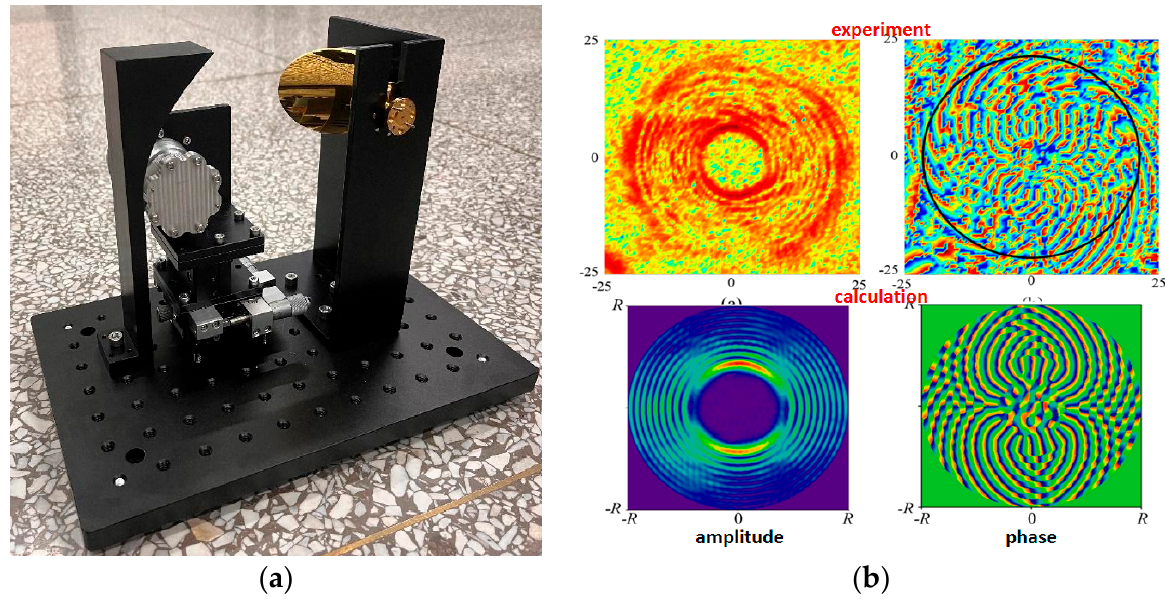
Figure 12. TE 25,10 mode generator: ( a ) established system including a phase correcting mirror, a quasi-parabolic mirror, and a coaxial cavity; ( b ) contrast between the experimental and calculation results for the aperture field distribution of the mode generator output.